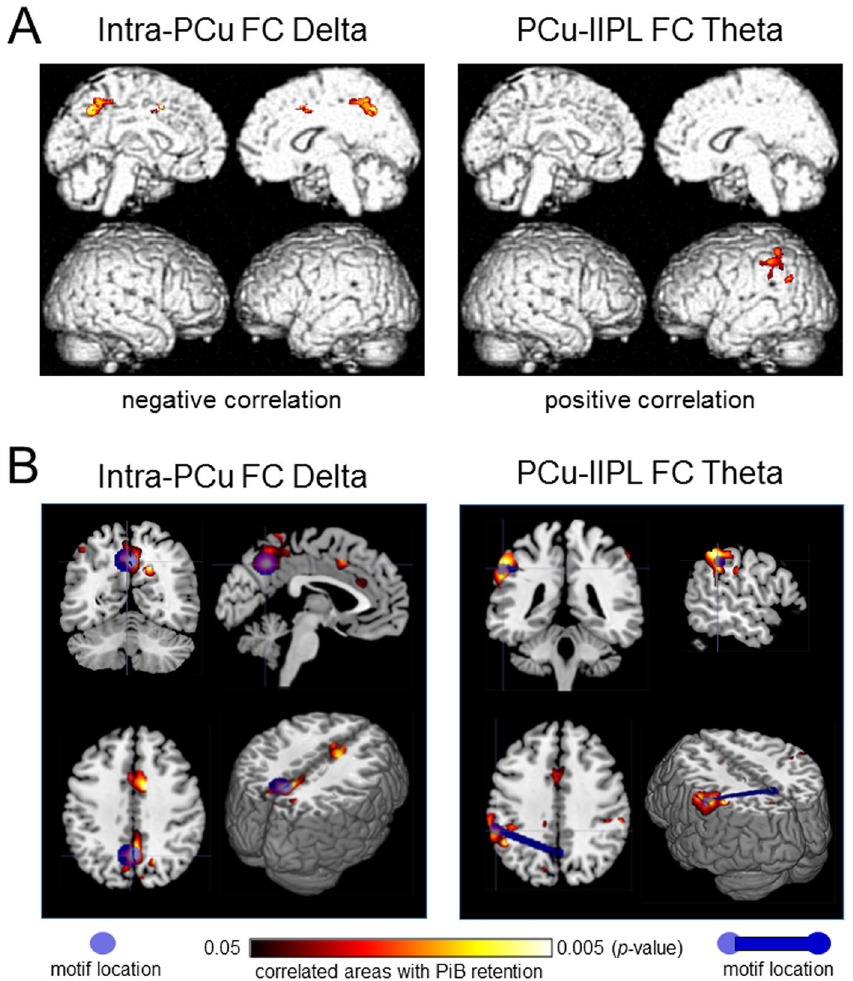
Figure 4. Results of the within-group correlation and regression analyses. ( A ) Results of regression analysis between PiB-SUVR images and values of MEG FC markers. Correlated areas within a DMN-ROI mask are visualized. The height threshold is p < 0.01 (uncorrected), and the extent threshold is k = 100 voxels in all images. ( B ) Topographical relationships between the network motif and the correlated areas between the FC values and PiB retention. The motif locations are represented by the center of gravity at each ROI. SUVR: standardized uptake value ratio, FC: functional connectivity, DMN: default mode